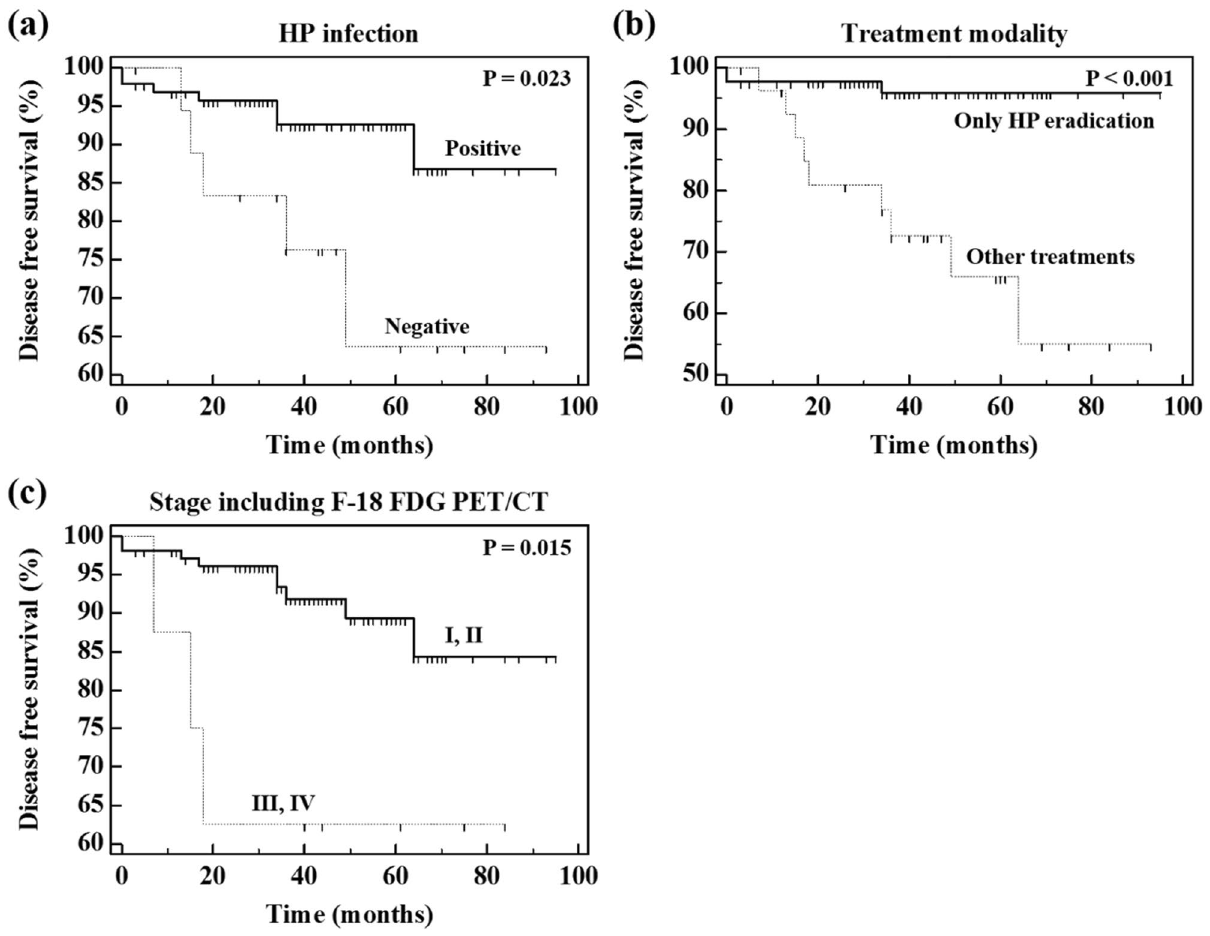
Figure 2. Kaplan–Meier curves of DFS with respect to HP infection ( a ), treatment modality ( b ), and stage including F-18 FDG PET/CT ( c ). This figure was made using MedCalc statistical software version 12.7.5.0 for Windows (Ostend, Belgium; https:// www. medca lc. org). DFS, disease free survival; HP, helicobacter pylori ; F-18 FDG, fluorine-18-fluorodeoxyglucose; PET, positron emission tomography; CT, computed